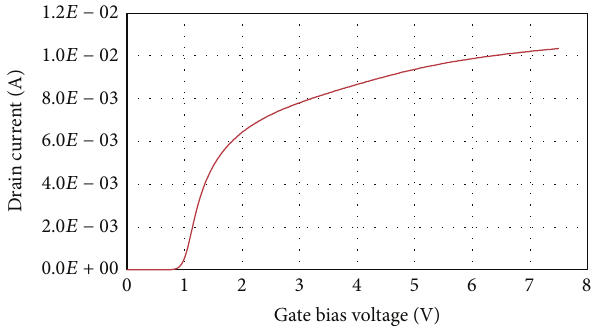
Figure10:Idvgcurveofthis500 VNLDMOSwitharea=0.816 mm 2 at 𝑉 = 0.1 V. The 𝑅 is 7.88 ohm ∗ mm 2 dd sp